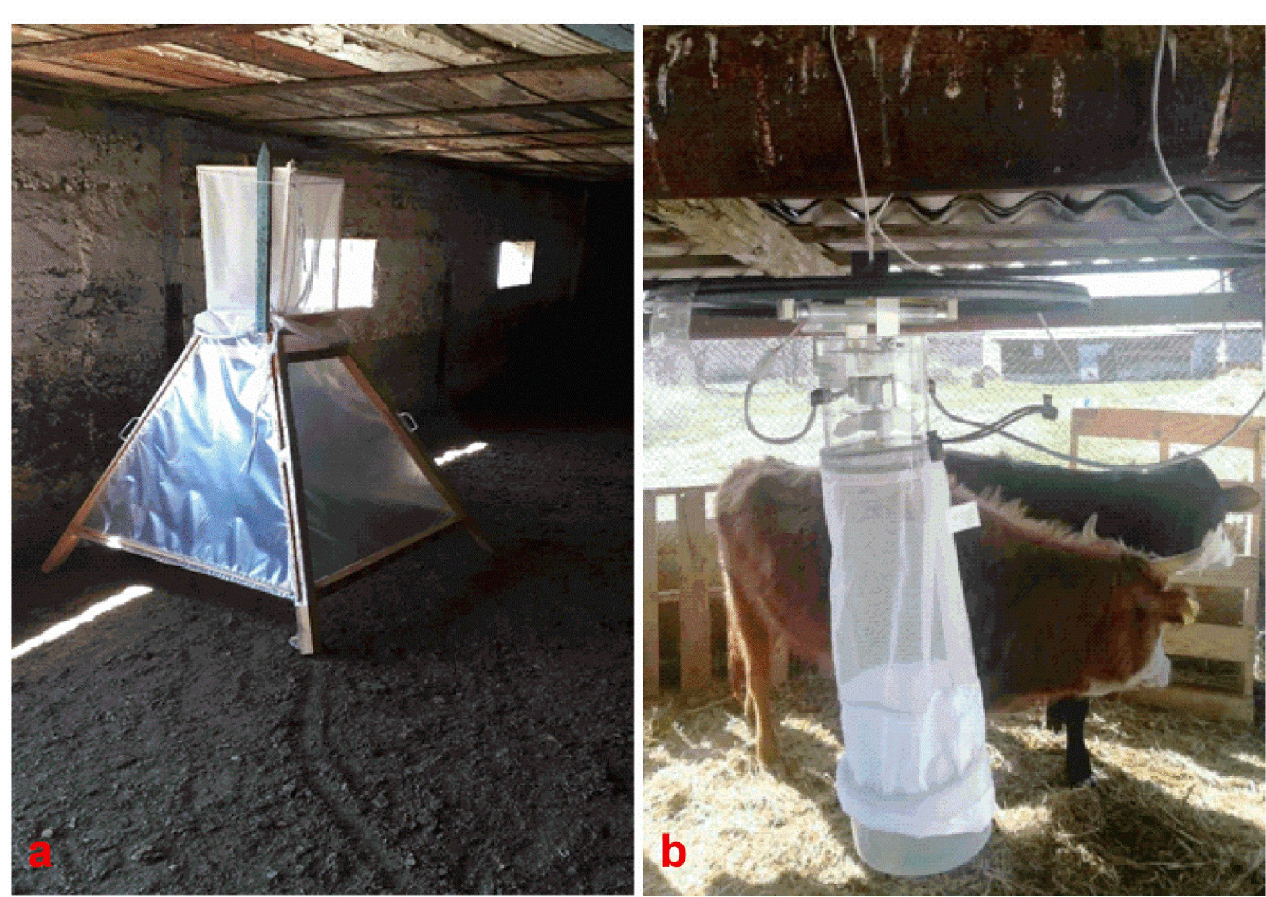
Fig 1. a–fly-catching unit (pyramid). b–Miniature CDC light trap with UV